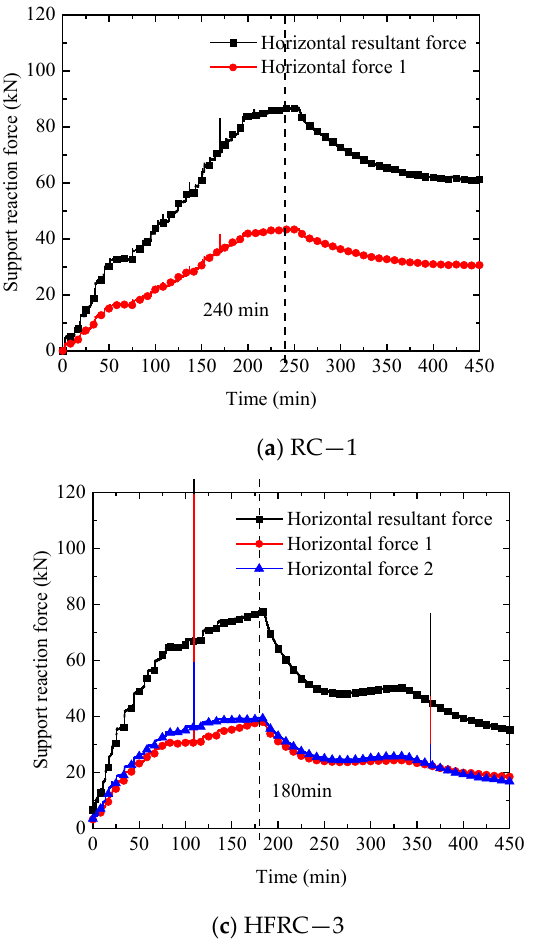
Figure 14. Vertical displacement–time curves: ( a ) RC—1; ( b ) RC—2; ( c ) HFRC—3; ( d ) HFRC—4; and ( e ) HFRC—5.